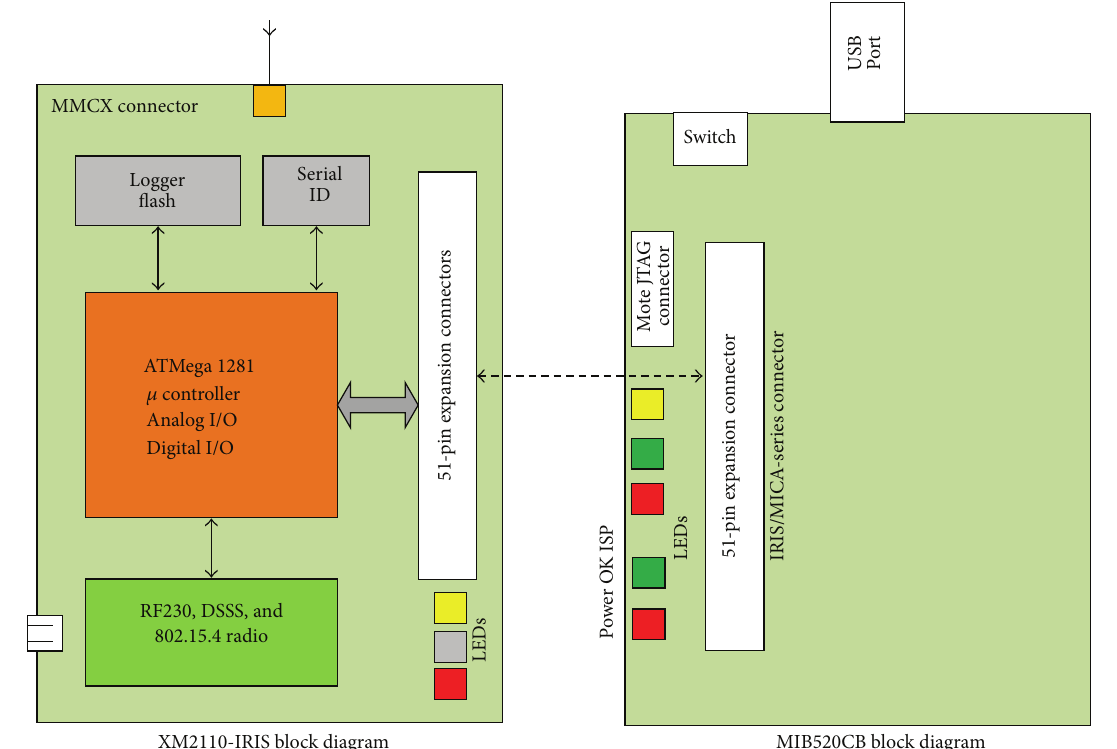
Figure 2: Structure of the base station.